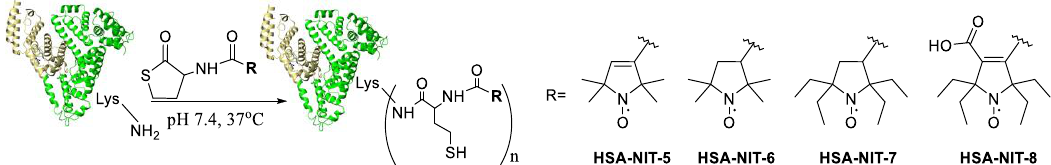
Figure 1. Synthetic route to obtain HSA-nitroxide conjugates (HSA-NIT). HSA is shown schematically as a heart-like structure of helical ribbons.